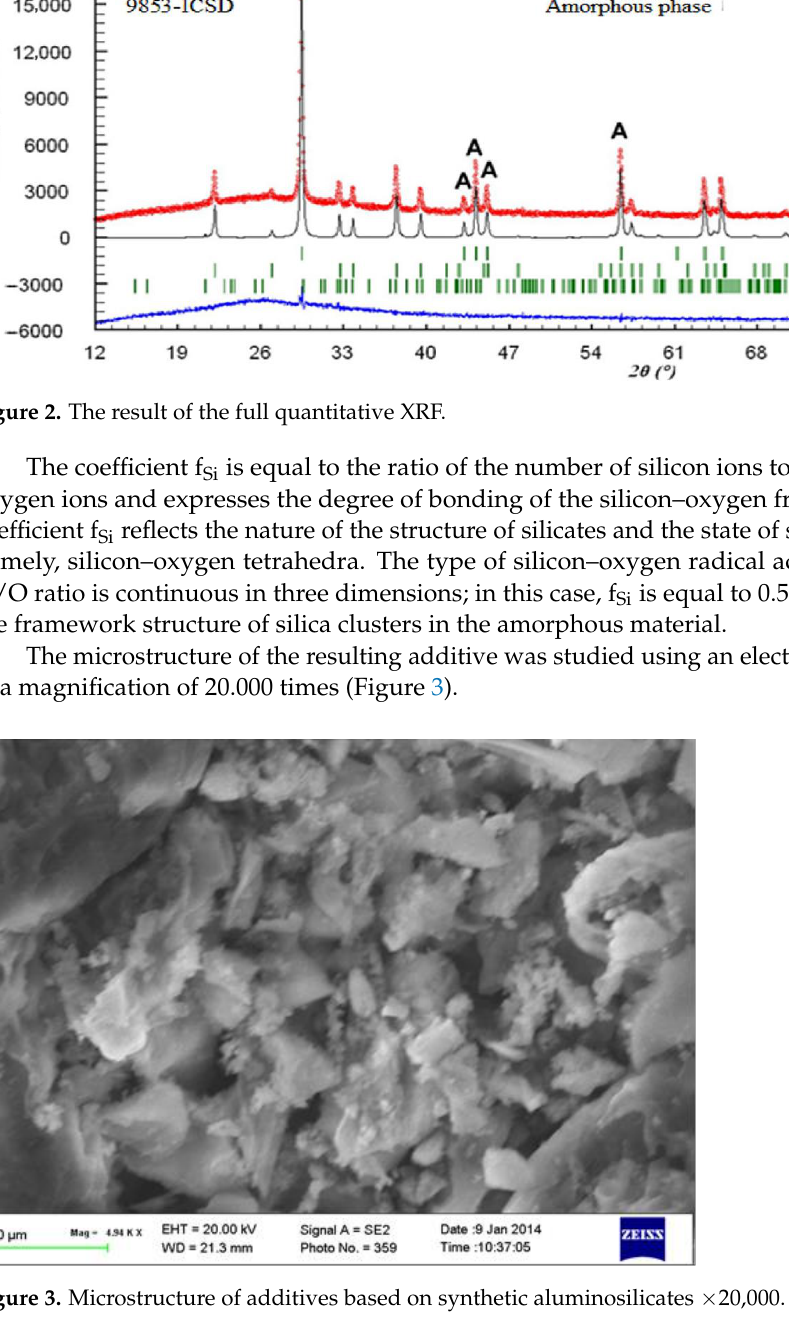
Table 6. Granulometric composition of the additive.